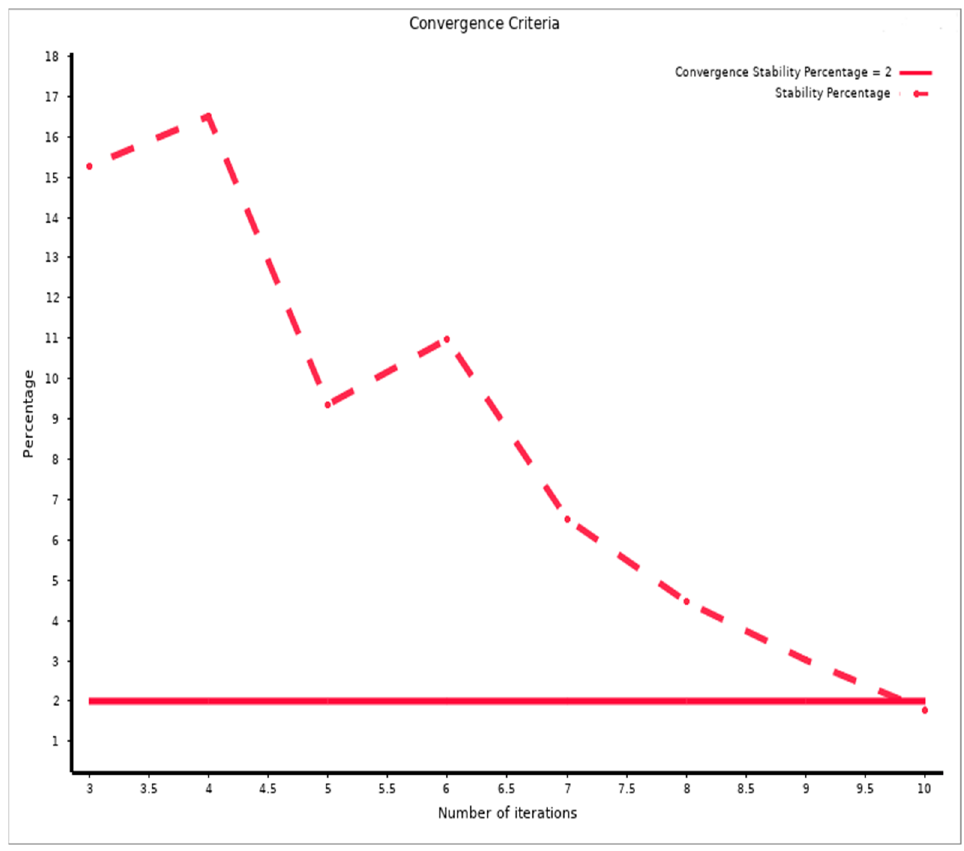
Figure 9. Convergence chart of the optimization processing, showing the stability percentage (2) of the population that reached the desired level of the stability by the 10th iteration. Figure 10 represents the sensitivity levels of the output parameters to the input pa- rameters. The results show that all input parameters, P1 to P4, have an impact on the post-HIP compact dimensions. As the bar chart shows, the P 1 (cid:48) output is impacted by changing not only input parameter P1, but is also significantly impacted by changing input parameter P3. Additionally, the sensitivity chart shows that P3 pre-HIP has the highest impact on P 3 (cid:48) (post-HIP compact). The P 4 (cid:48) output parameter is more sensitive to the P2 and P4